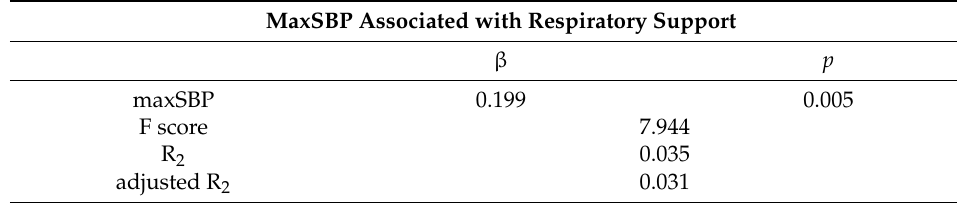
Table 5. Regression analysis of individual blood pressure-related parameters and the need for neonatal respiratory